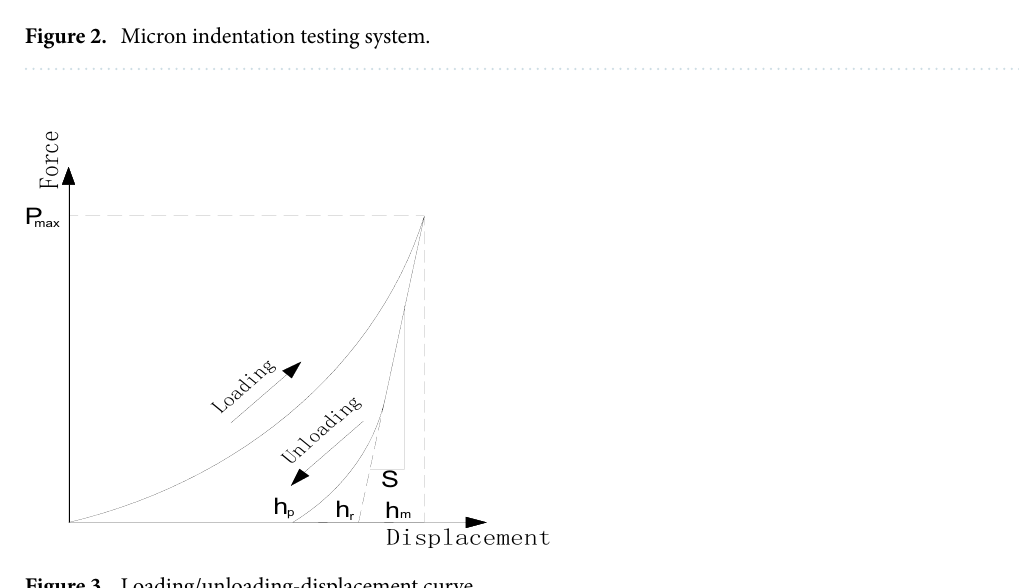
Figure 3. Loading/unloading-displacement